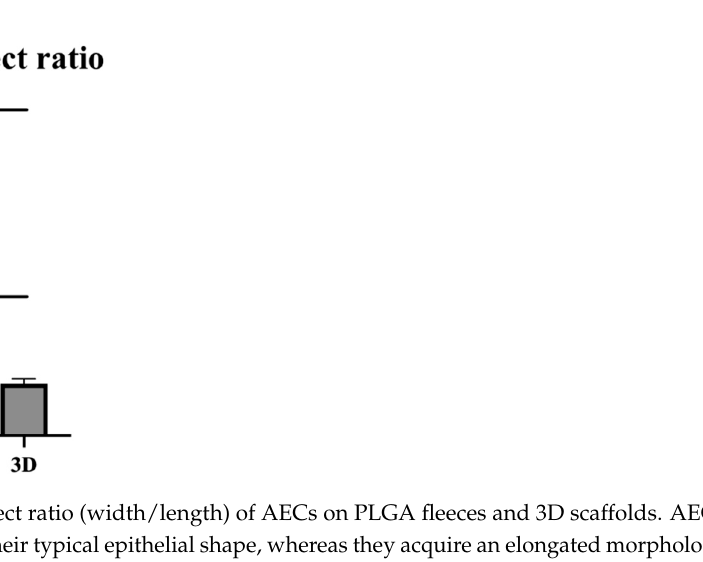
Figure 6. IF images of TNMD protein expression (green fluorescence) in AECs seeded on ( A ) Petri dishes used as CTR, ( B ) PLGA fleeces and ( C ) 3D scaffolds; DAPI (blue fluorescence)-counterstained nuclei.